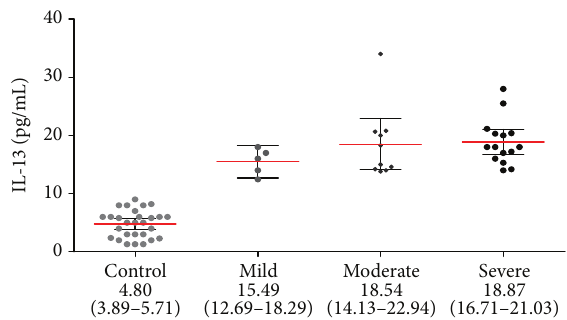
Figure 1: IL-13 concentration in serum of eRA disease patients with different clinical activity stages (black circles represent IL-13 con- centration, pg/mL in individual serum samples; red lines represent mean values accompanied by 95% confidence interval, represented as black horizontal bars).